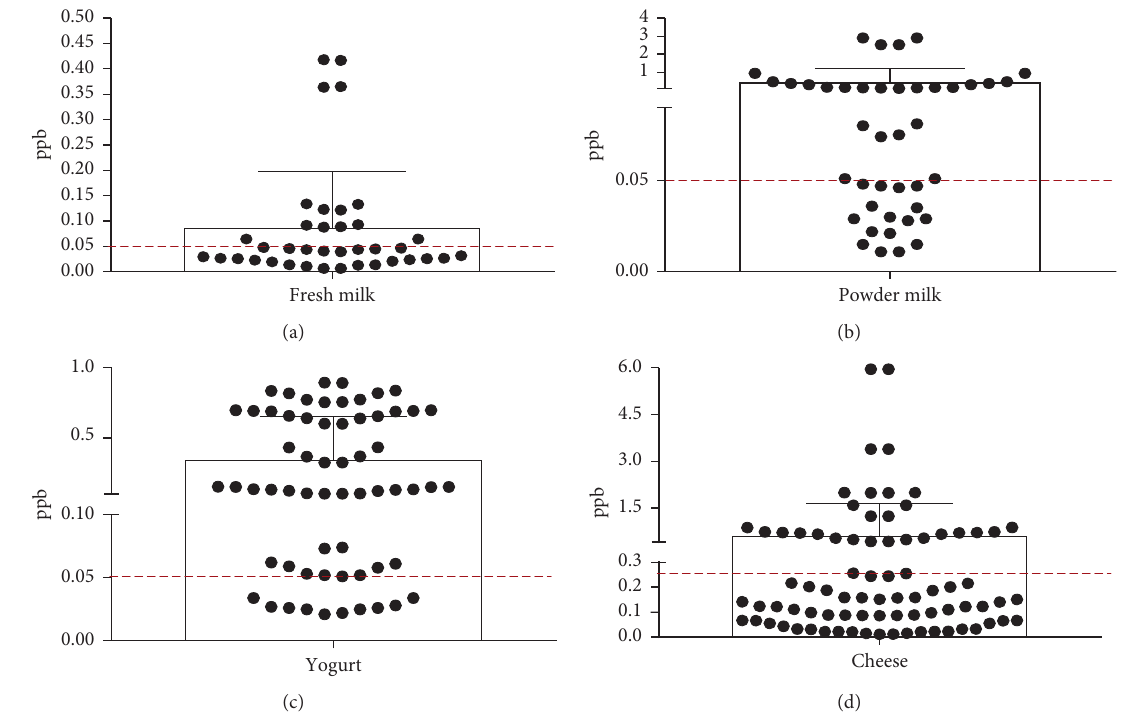
Figure 2: Distribution of aflatoxin M1 concentration in dairy product samples.